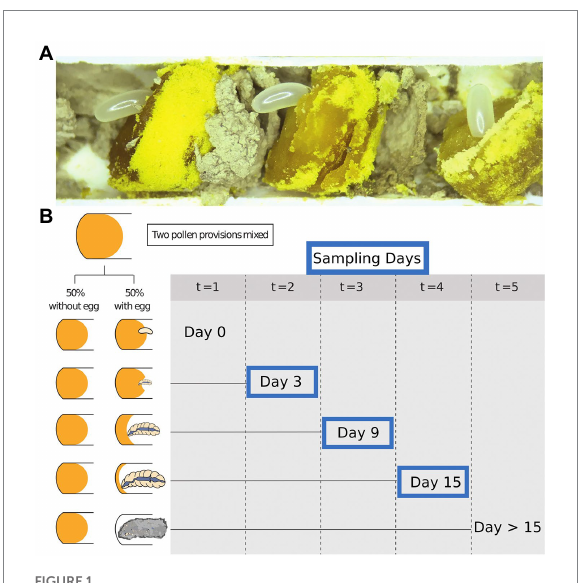
FIGURE 1 Samples and study design. (A) The exposed cells of Osmia cornifrons . (B) Experimental overview shows sampling time during our experiment: points; (t = 0 = day 0; t = 1 = day 3; t = 2 = day 6 ; t = 3 = day 9; t = 4 = day 12; and t = 5 = day 15). Only Day 3, 9, and 15 were selected for bacterial diversity